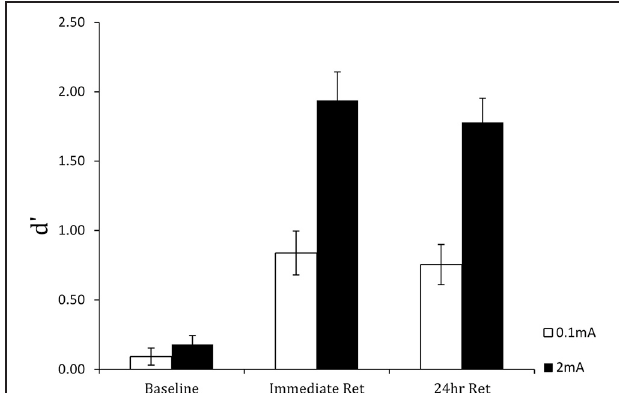
FIGURE 7 | Perceptual sensitivity ( d (cid:2) ) of threat detection in the pre-training baseline, immediate post-training retention test, and 24-hour retention test blocks for active (2mA) and sham (0.1mA) brain stimulation groups. From Falcone et al.